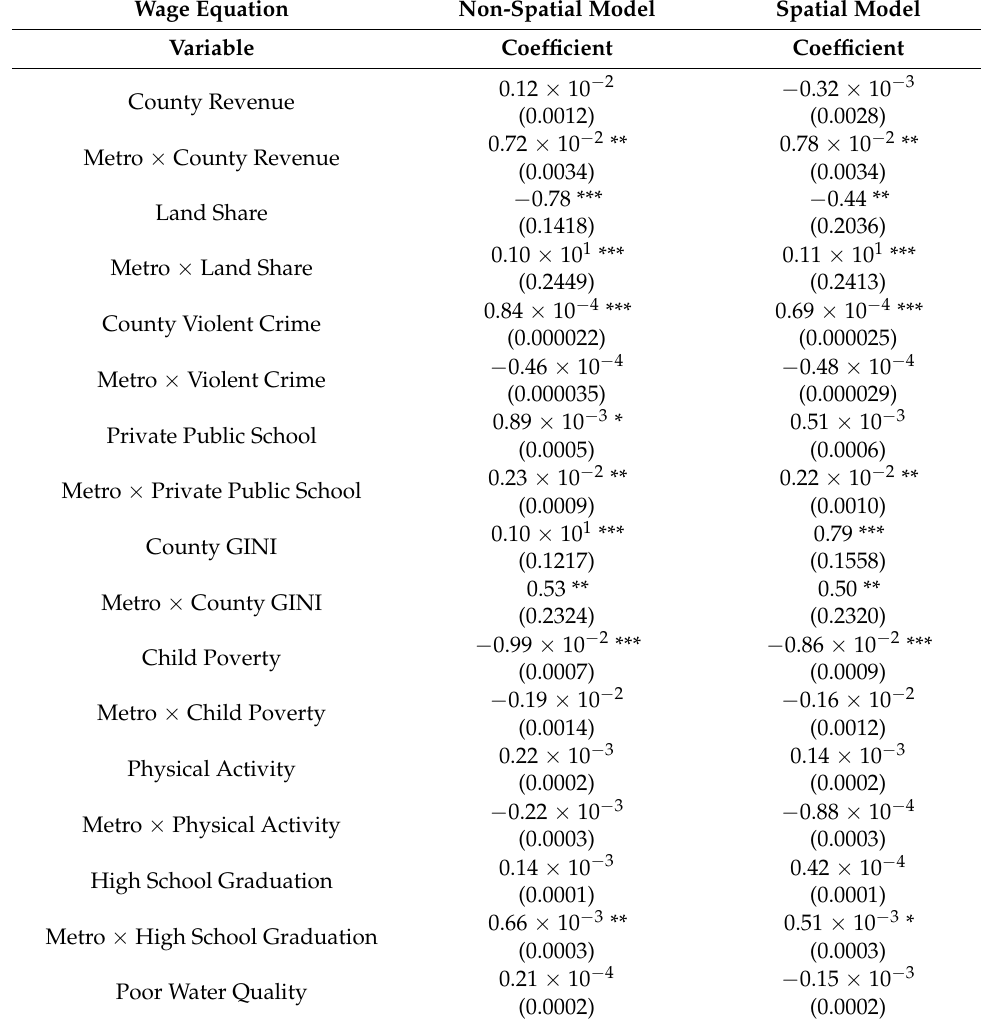
Table A16. Reduced-form estimates: wage equations with a metro dummy and cross-products for the continental United